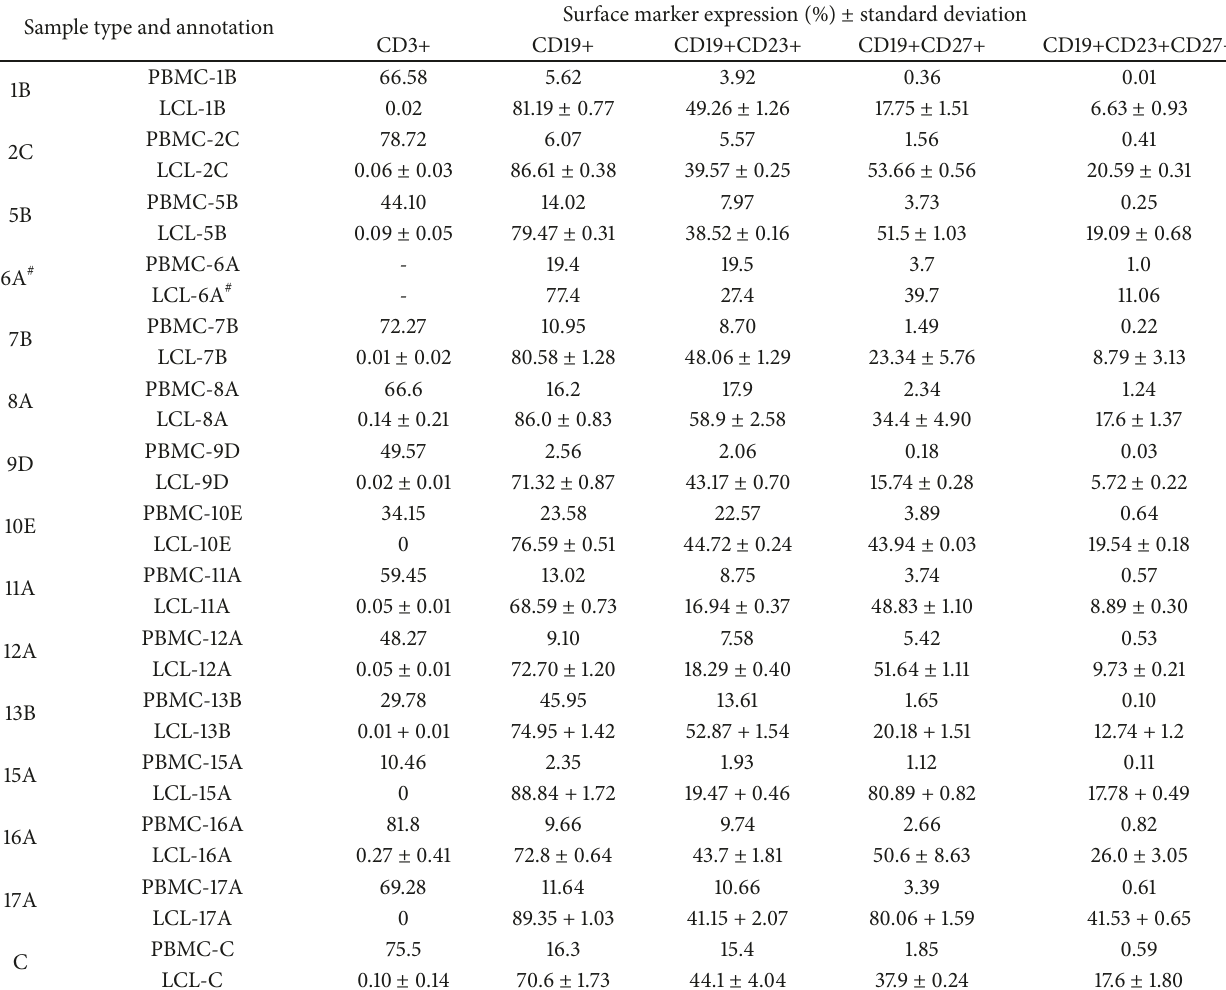
Table 3: Surface marker expression of PBMCs and LCLs derived from participated subjects. Sample type and annotation